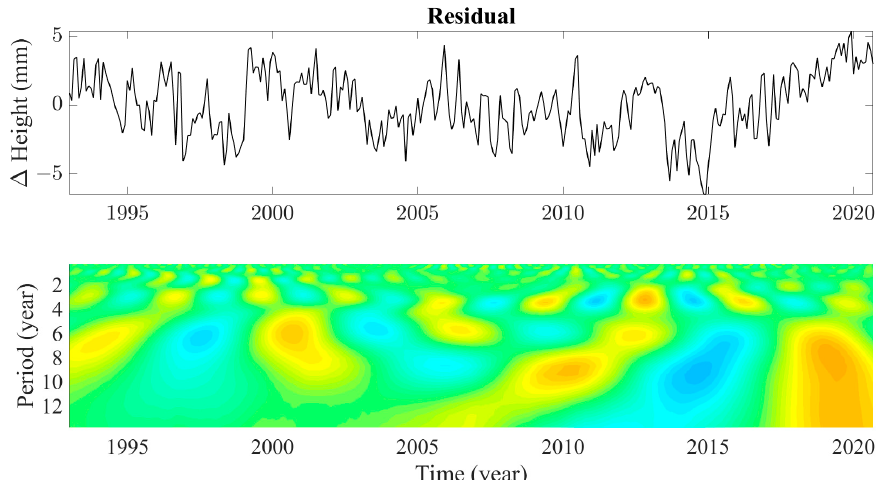
Figure 6. The Residual ( t ) (in Equation (2)) time series after removal of the least-squares fit of the five climatic oscillations from GMSL-ID ( t ), i.e., the difference between the two curves in Figure 5a, along with its time–frequency (real-valued) Morlet wavelet spectra.